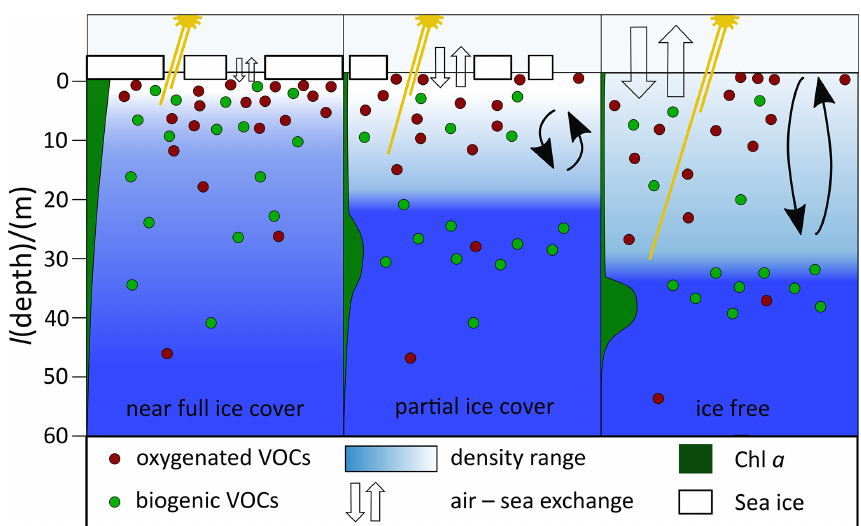
Figure 11. Schematic summarizing the impact of seasonal sea ice melt on dissolved gas concentrations. Methanol, acetone and acetaldehyde are shown as “oxygenated VOCs”, and DMS and isoprene are shown as “biogenic VOCs”. The shorter light beam represents UV rays, while the longer one represents